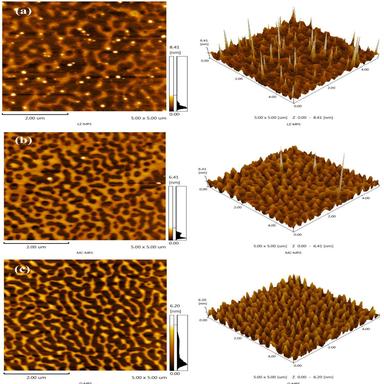
AFM images of LZ-MPS (a), MC-MPS (b), and G-MPS (c) at planar and cubic.